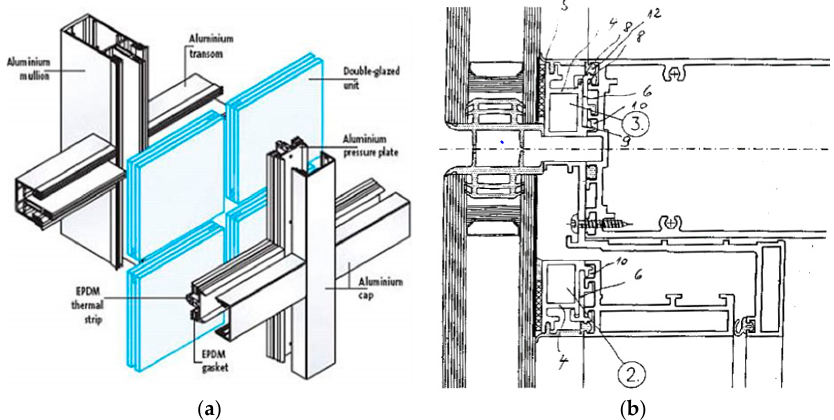
Figure 5. Unitized and Curtain-wall assemblies: ( a ) General Curtain Wall build up [14]; ( b ) Curtain-wall assembly in a modular construction system [15].